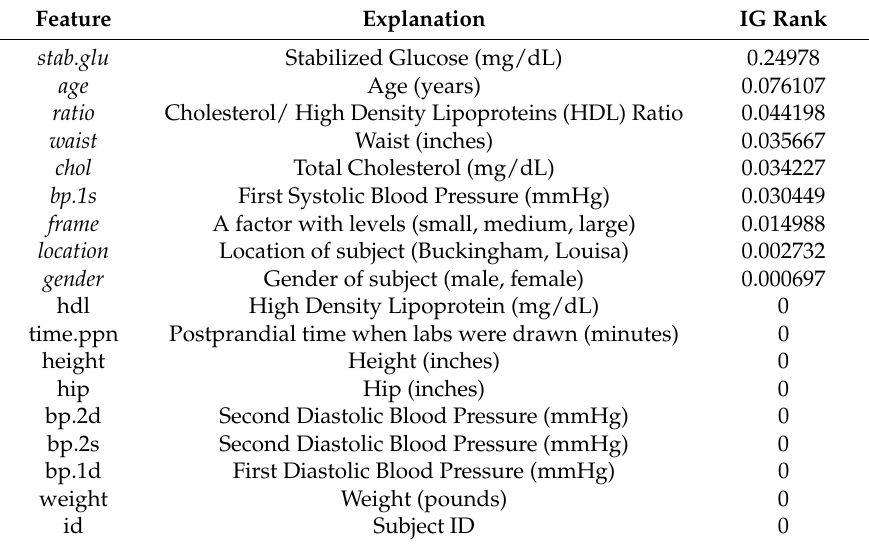
Table 1. The feature of dataset I and its Information Gain (IG) Rank.